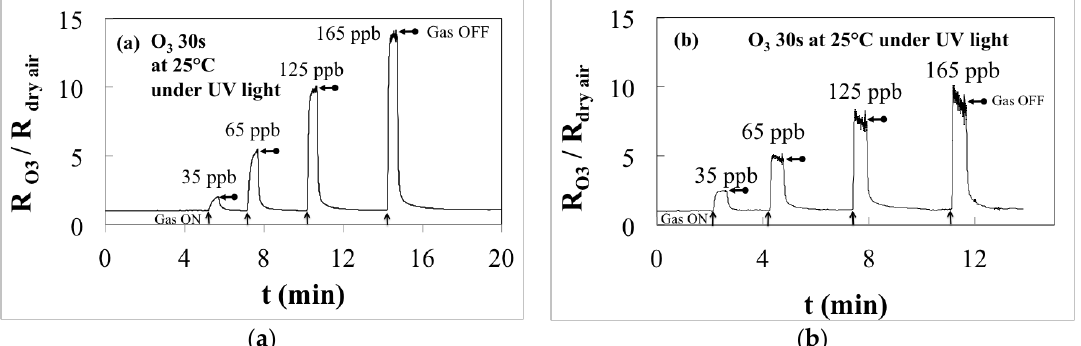
Figure 2. Normalized responses at 25 °C for O 3 sensors based on ZnO at 30 mg/mL (post-annealed at 80 °C) under UV light ( a ) without EA (S1) and ( b ) with EA (S2).